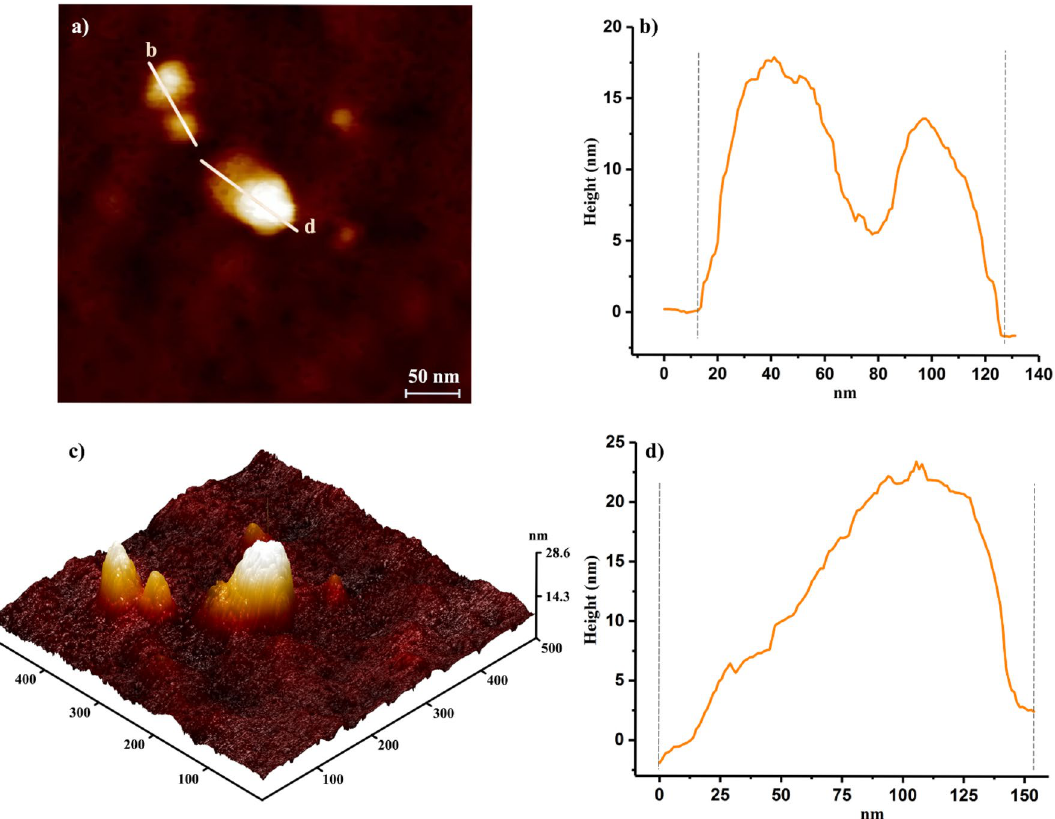
Figure 3. AFM images of the virus aggregation at 2 min ozone exposure time; ( a ) 2D image of aggregated virus particles. ( b ) and ( d ) The corresponding height profiles of the aggregated virus particles reflecting AFM image of ( a ) and ( b ). ( c ) 3D image of the same virus